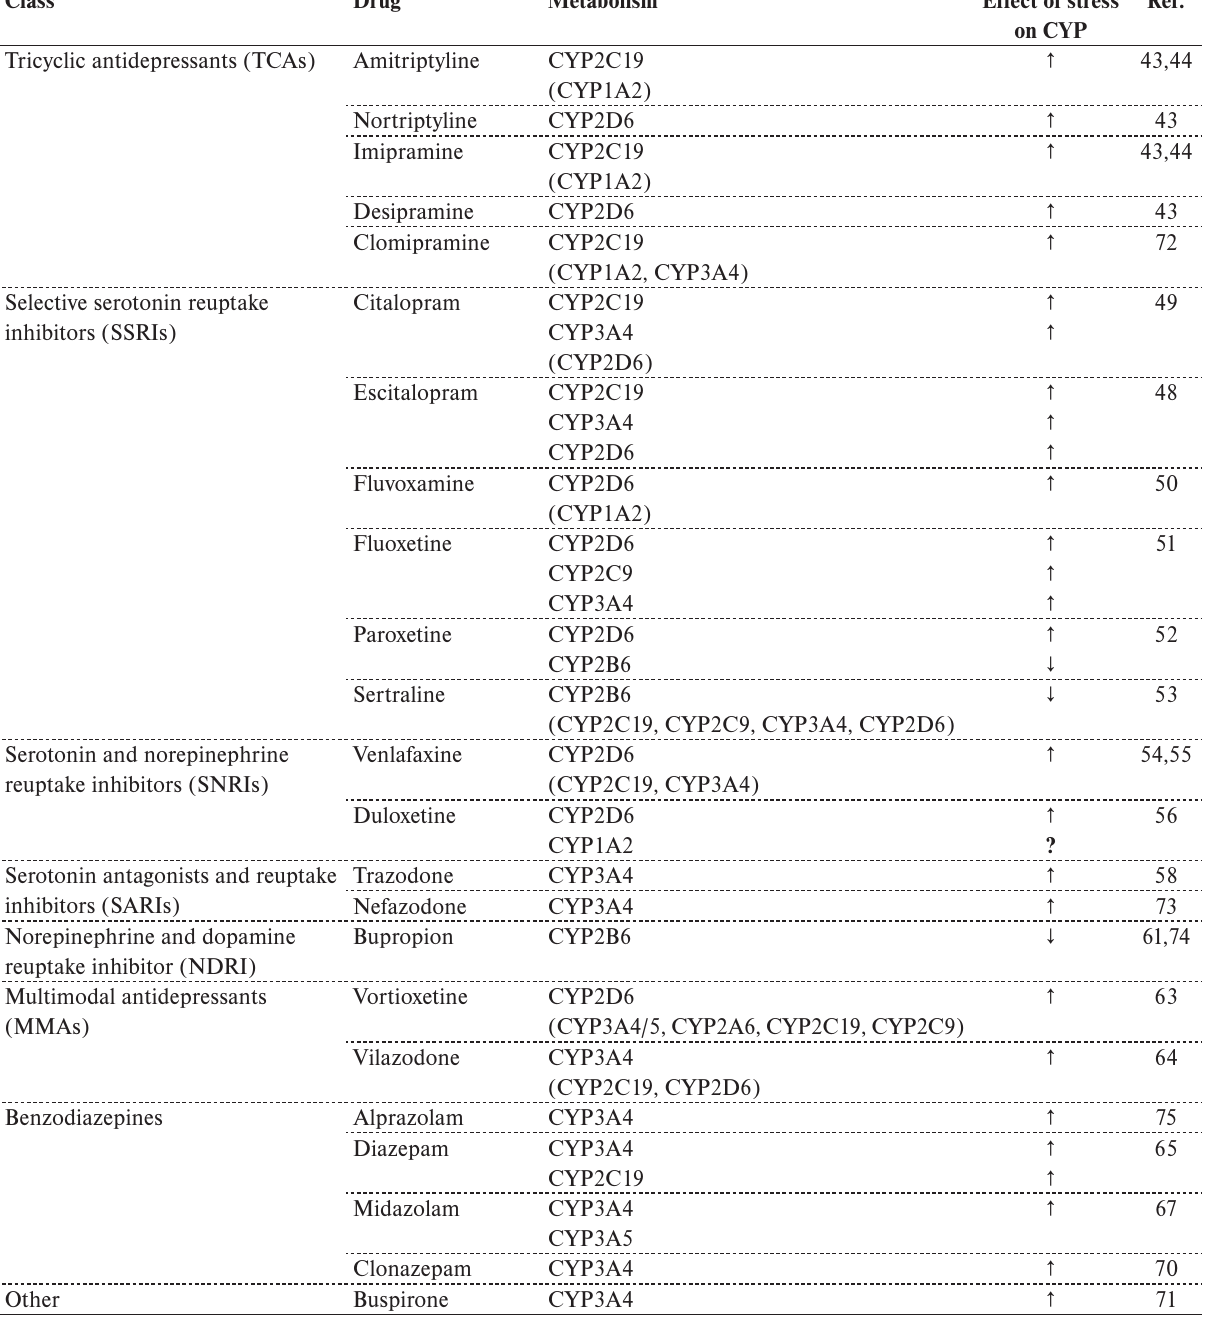
Table 1. CYP metabolism of selected antidepressants and anxiolytics with indications of potential effect of stress (↑ – increased and ↓ – decreased expression/activity of CYP). Minor metabolic pathways are indicated in parenthesis. Individual drugs are divided into corresponding